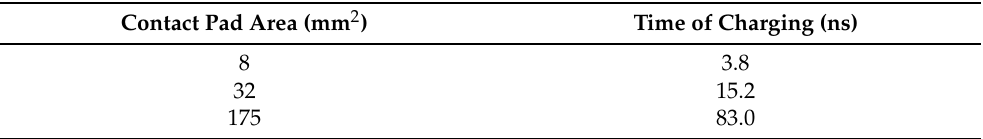
Table 1. The time needed to charge up the contact pads of different areas to the mean voltage of the anode of 2820 V for a mean arc current of 500 mA.